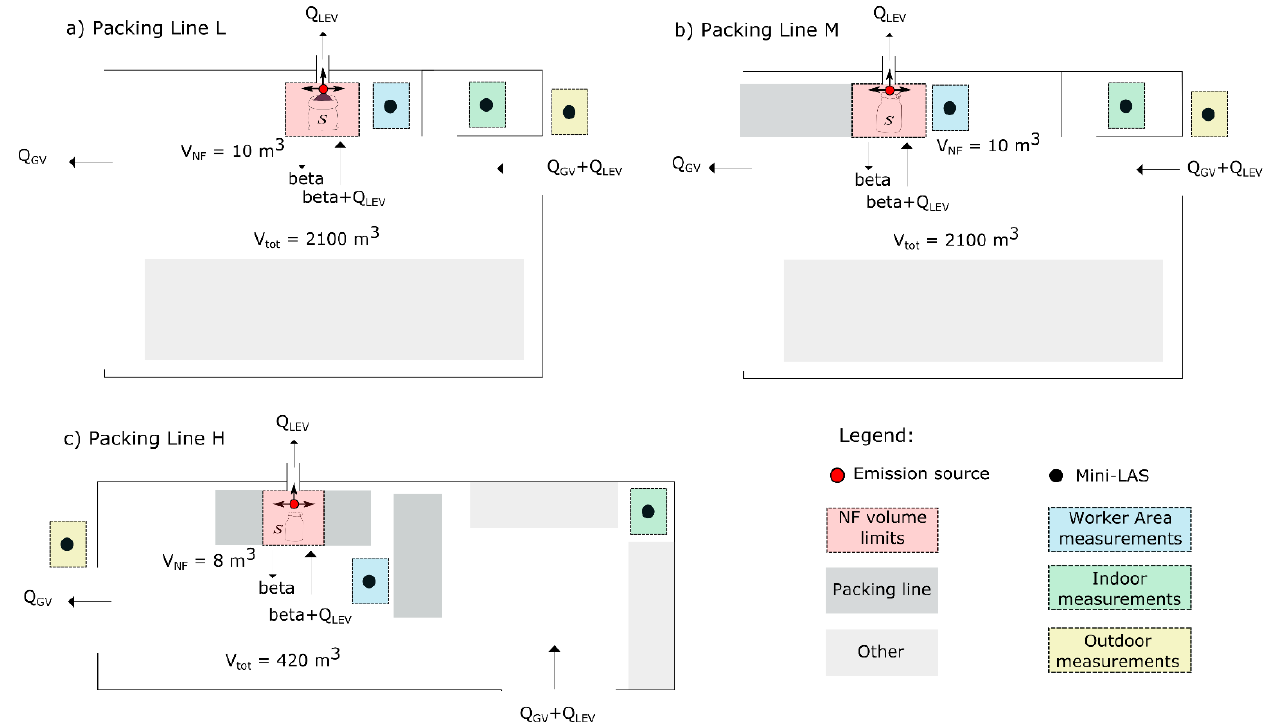
Figure 1. Modelling layout for Industrial Setting #1 containing filling lines L ( a ) and M ( b ), and for Industrial Setting #2 containing filling line H ( c ).